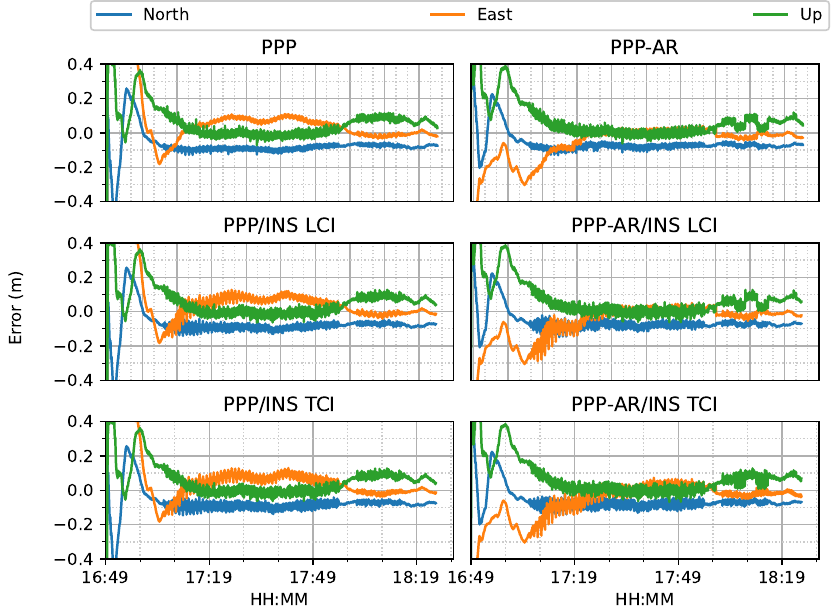
Figure 7. PPP/INS results of the train positioning test on 7 March 2022.